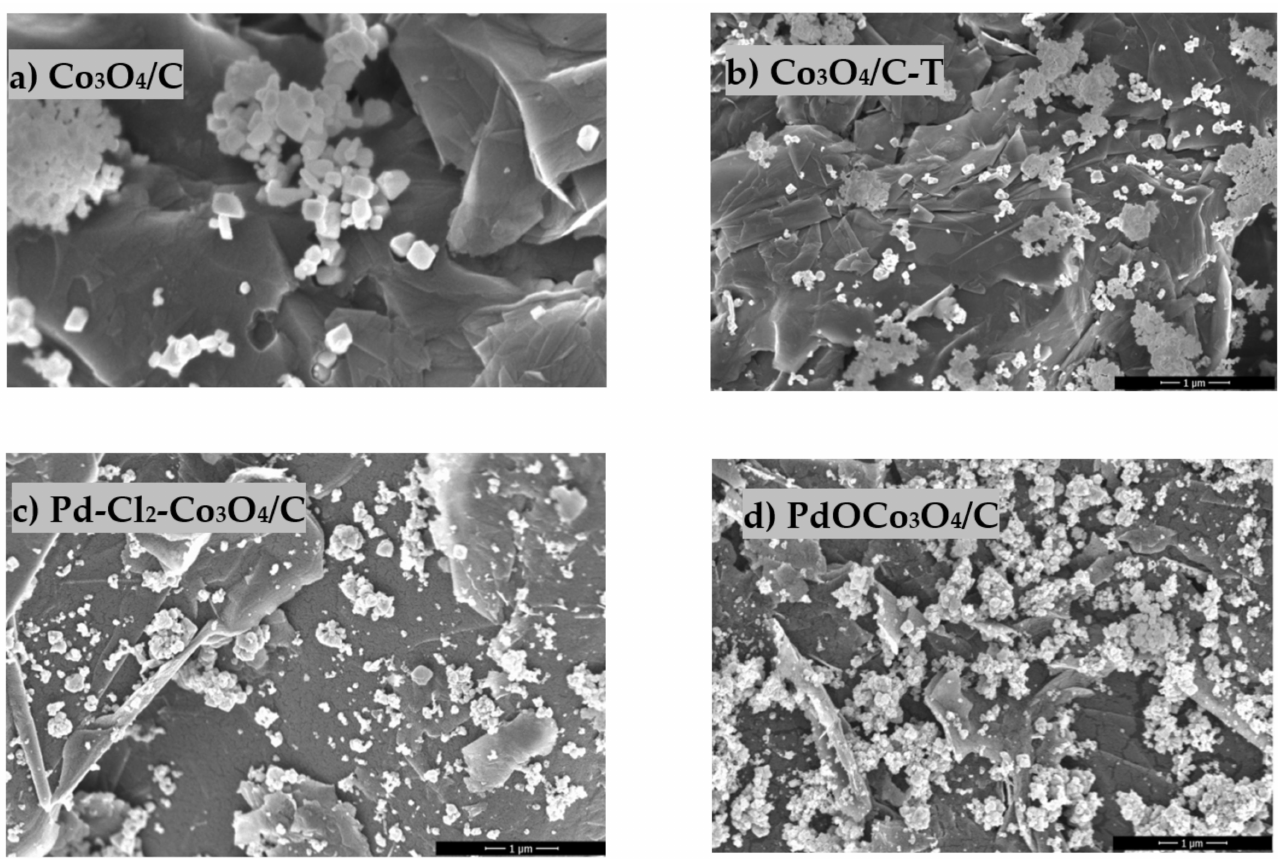
Figure 3. SEM images of the Co 3 O 4 /C ( a ), Co 3 O 4 /C-T ( b ), Pd-Cl 2 -Co 3 O 4 /C ( c ), and PdOCo 3 O 4 /C ( d )